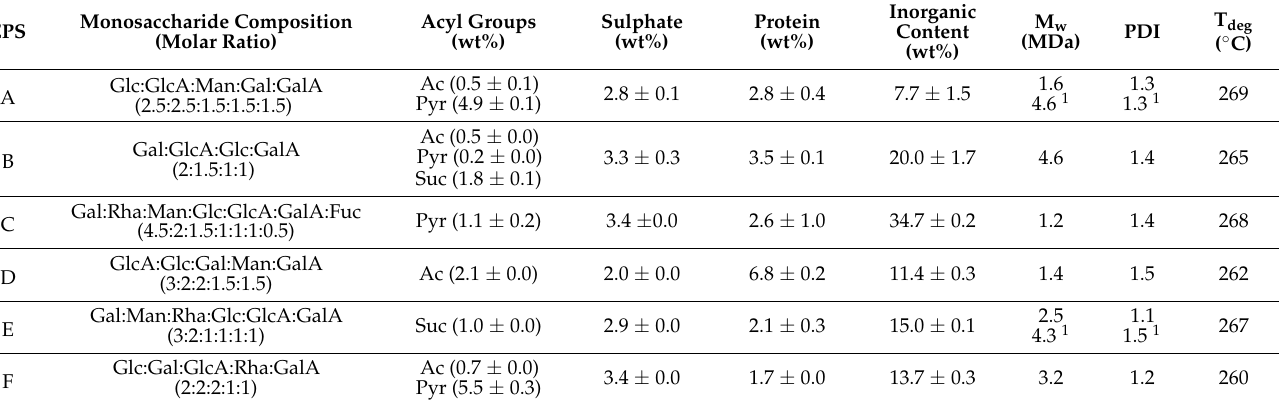
Table 1. Characterisation of the EPSs produced by Alteromonas strains isolated from French Polynesia marine environments: carbohydrate (Fuc, fucose; Gal, galactose; GalA, galacturonic acid; Glc, glucose; GluA, glucuronic acid; Man, mannose; Rha, rhamnose) and acyl groups (Ac, acetate; Pyr, pyruvate; Suc, succinate) composition; sulphate, uronic acids, protein, and inorganic salts content; average molecular weight (Mw); polydispersity index (PDI); and thermal degradation temperature (T deg ). Reproduced from Conc ó rdio-Reis et al.